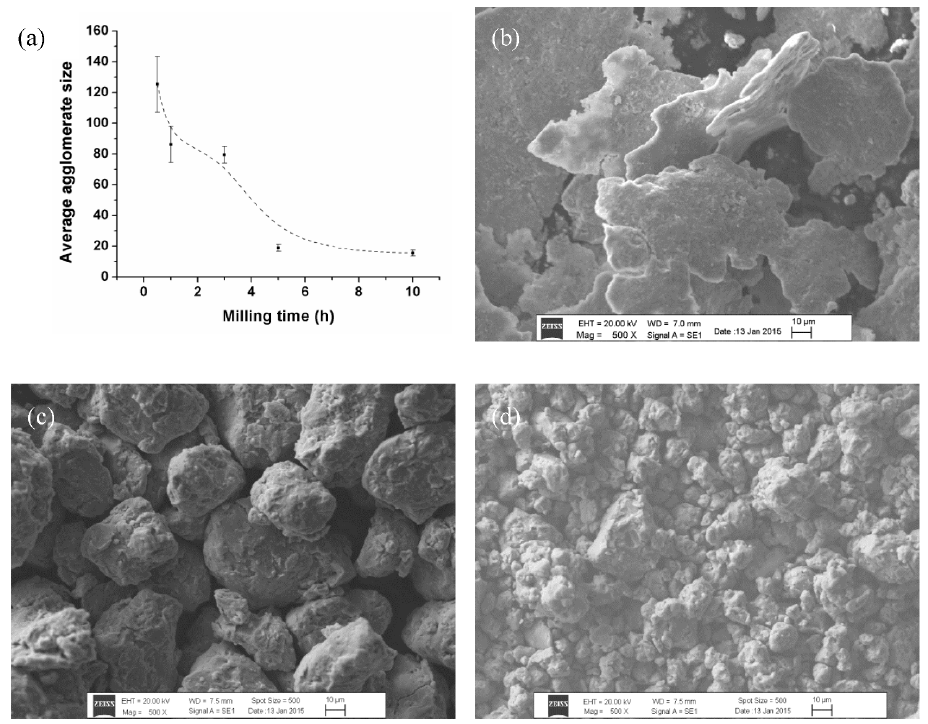
Figure 1. ( a ) Average agglomerate size as a function of milling time. Morphology of the powders after ( b ) 0.5; ( c ) 3; and ( d ) 10 h of milling.